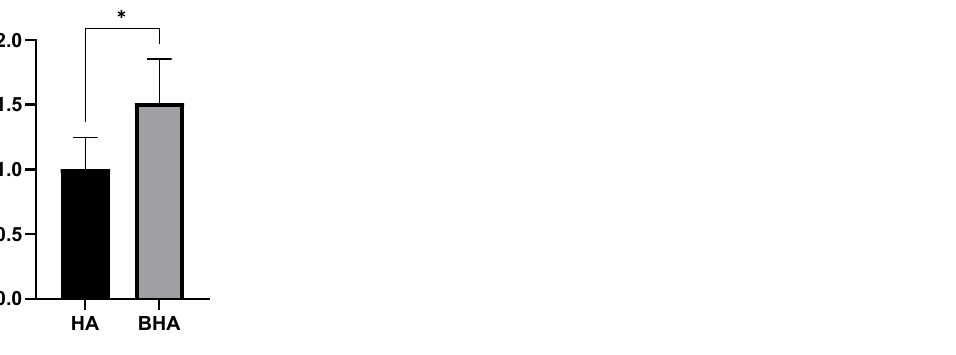
Figure 1. Relative compressive strength of BHA and HA. Each bar shows the mean ± SD ratio. * p < 0.05 based on the unpaired t -test.